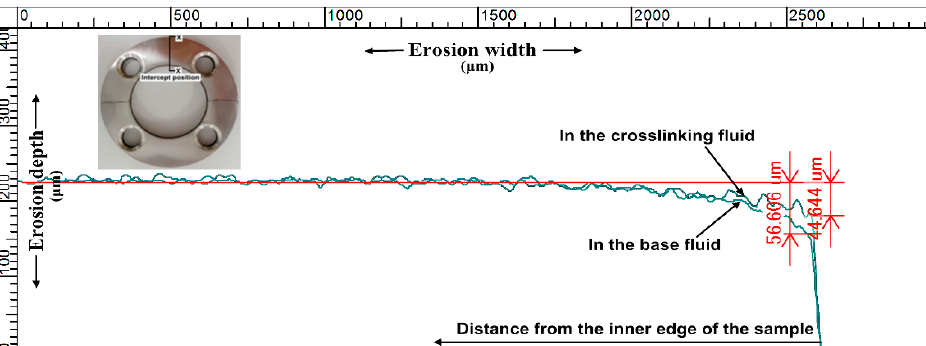
Figure 8. The comparison of the erosion depth between the particles in the base fluid and the crosslinking fluid.